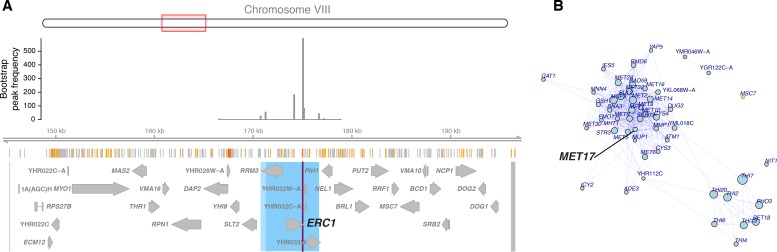
The ERC1 hotspot.(A) The region surrounding the ERC1 hotspot. Legend as in Figure 4B. The entire region tested in the bootstrap analysis is delimited by two markers shown as grey lines at the outer edges of the plots. These markers and the peak markers are padded to span all variants that are in perfect linkage disequilibrium with the given marker. (B) A visual representation of the top 50 genes affected by the hotspot. Each gene is shown as a dot, with size scaled as a function of the size of the effect of the hotspot on the gene. We show genes with lower expression linked to the BY allele. Genes with a local eQTL anywhere in the region tested in the bootstrap analysis are indicated by orange circles. Edges between genes indicate co-expression in a gene regulatory network (Zhang and Kim, 2014). Blue edges: positive co-expression, red edges: negative co-expression. Note the group of genes with methionine-related functions, including MET17.